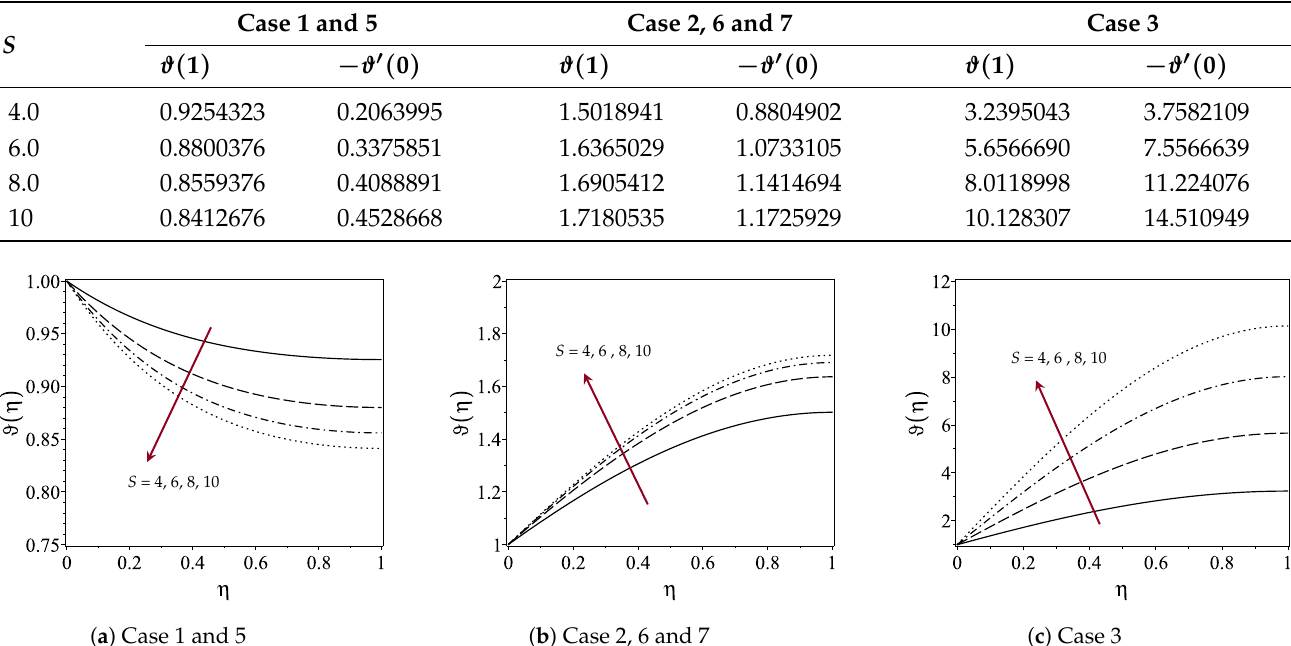
Figure 3. Variation of temperature distribution ϑ ( η ) with the unsteadiness parameter S at Pr =1 and G ∗